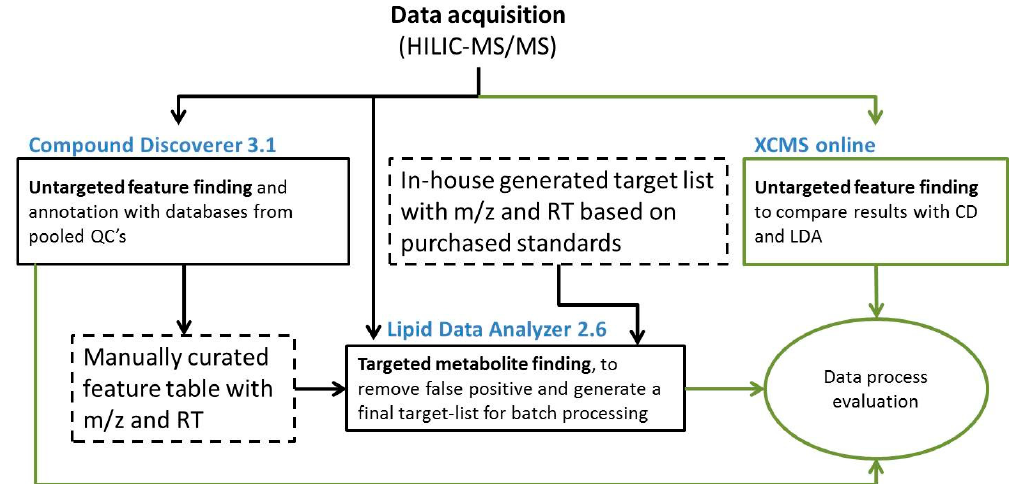
Figure 1. Flowchart of the combined untargeted and target-list based metabolomics workflow used in this study (black) with the extension of data process evaluation of the three software tools (green). Blue titles show software tools used, dashed boxes are target lists based on reference material and an untargeted approach, and boxes with solid lines are the processing steps. (RT: Retention Time; m / z : mass to charge ratio) .